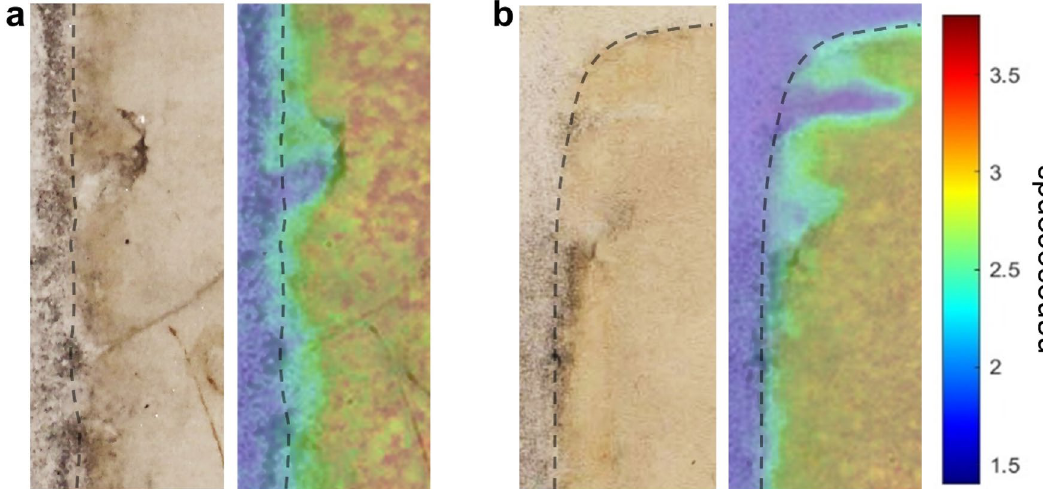
Figure 3. Photoluminescence lifetime imaging results of Folio 843 performed before the detachment of the passepartout ( a ) central left margin and ( b ) top left angle. In both cases, both the photograph of the area (left) and the photoluminescence lifetime map (right) are